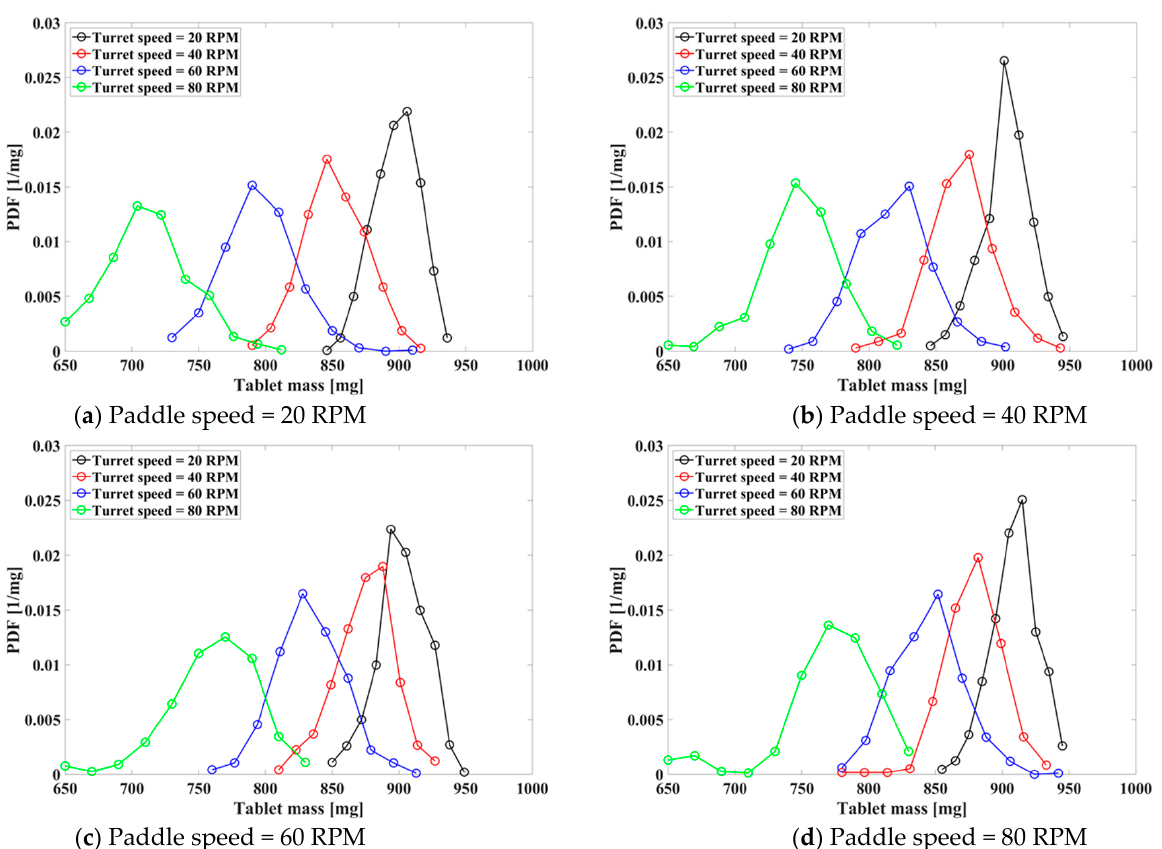
Figure 12. Images showing the effect of paddle speed and turret speed on tablet mass distribution at different paddle and turret speeds: ( a ) Paddle speed = 20 RPM; ( b ) Paddle speed = 40 RPM; ( c ) Paddle speed = 60 RPM; ( d ) Paddle speed = 80 RPM, at four different turret speeds of 20 RPM, 40 RPM, 60 RPM, and 80 RPM.